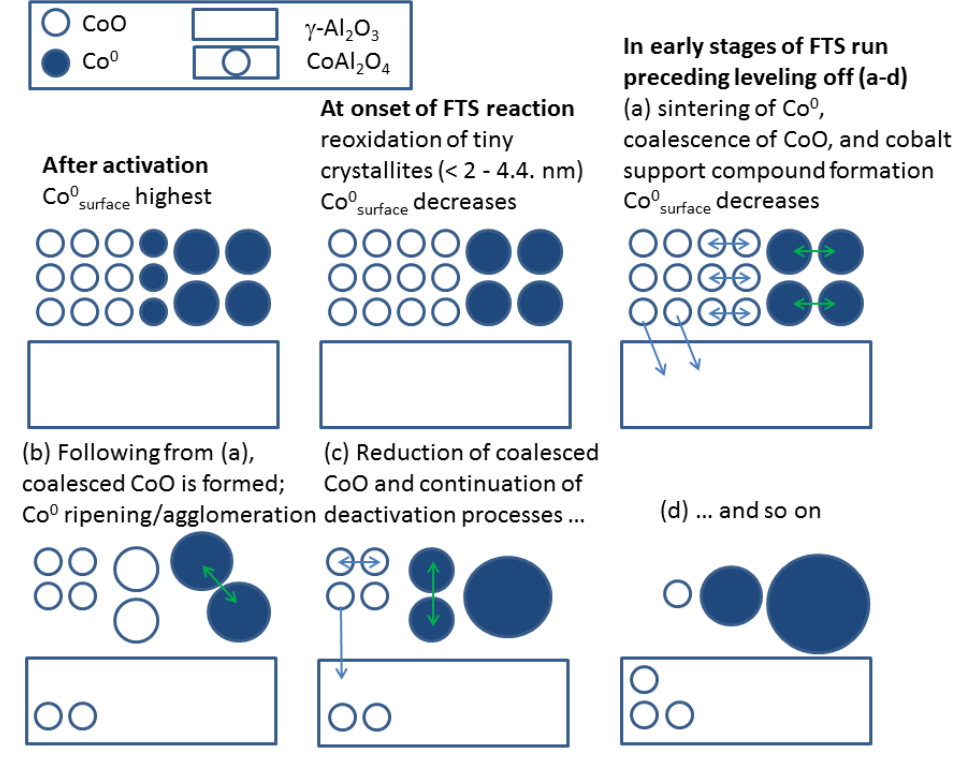
Figure 11. Proposed explanation for the deactivation of alumina-supported cobalt nanoparticles in research catalysts as a function of time on-stream. Adapted with permission from [42]. Copyright (2013) Elsevier [42]. The figure emphasizes why commercial catalysts adopt larger crystallite diameters for the purpose of